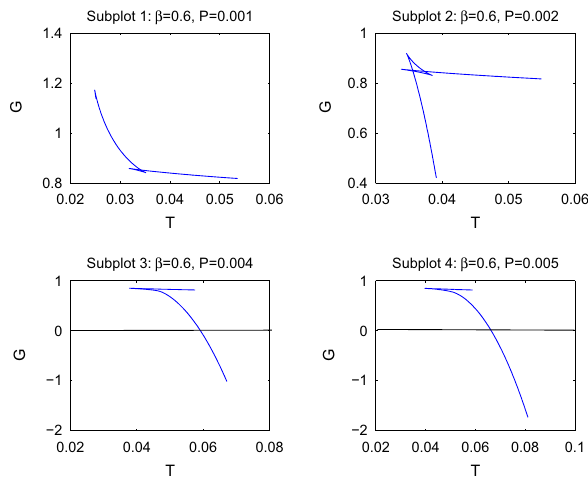
Fig. 10 TheplotoftheGibbsfreeenergy G vs T with q m = 1, β = 0 .